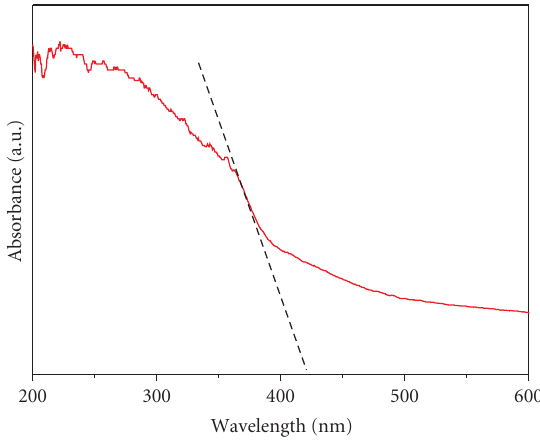
Figure 4: UV-Vis di ff use reflectance spectrum (DRS) for TiO 2 nanotube